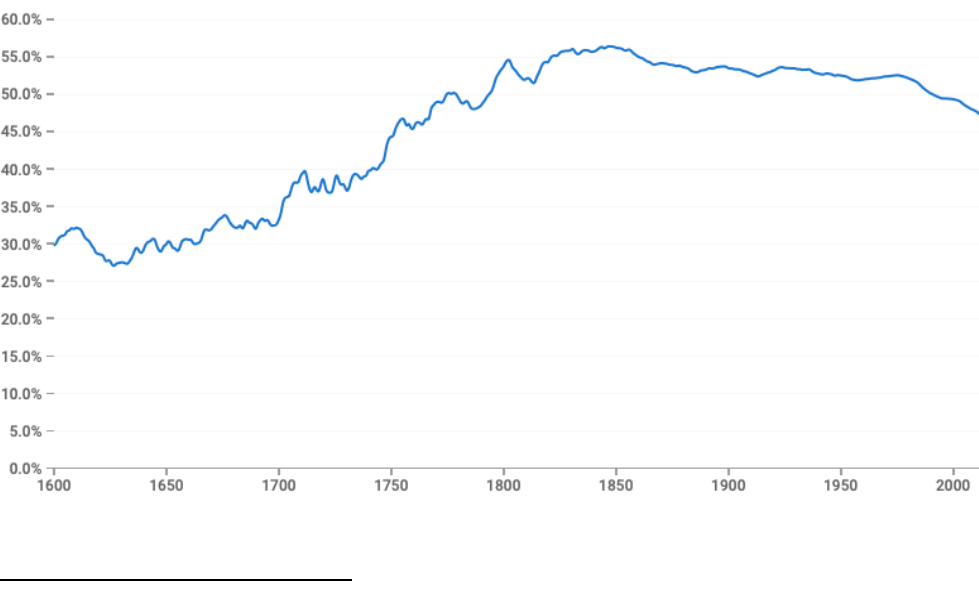
Figure 4. Percentage of negated _VERB_ más que as a fraction of all